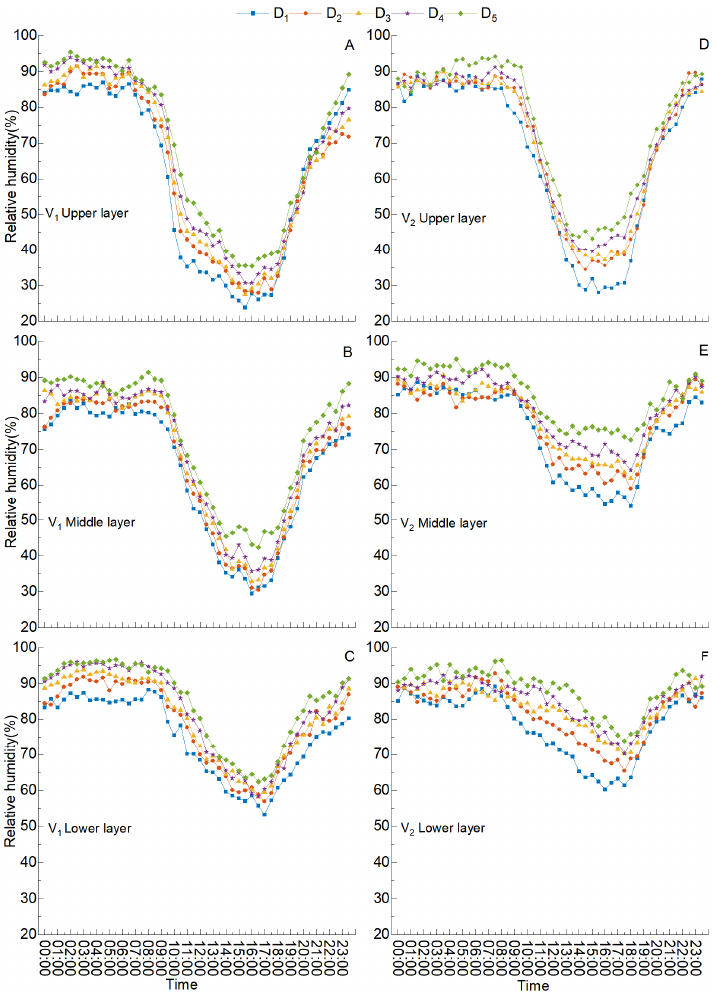
Figure 6. Effects of planting density on canopy relative humidity in uniformly sown winter wheat. V 1 , Xindong 50. V 2 , Sangtamu 4. ( A – C ) denote the upper, middle, and lower layers of Xindong 50, respectively, whereas ( D – F ) refer to the upper, middle, and lower layers of Sangtamu 4, respec- tively.